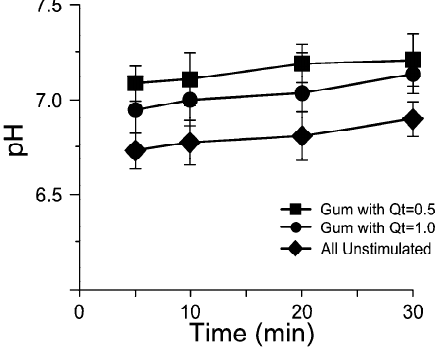
Figure 2. The changes in salivary pH (mean ± S.D.) for 32 participants (three samples for each participant, for three experiments) over a 30 min period, collected at 5, 10, 20, and 30